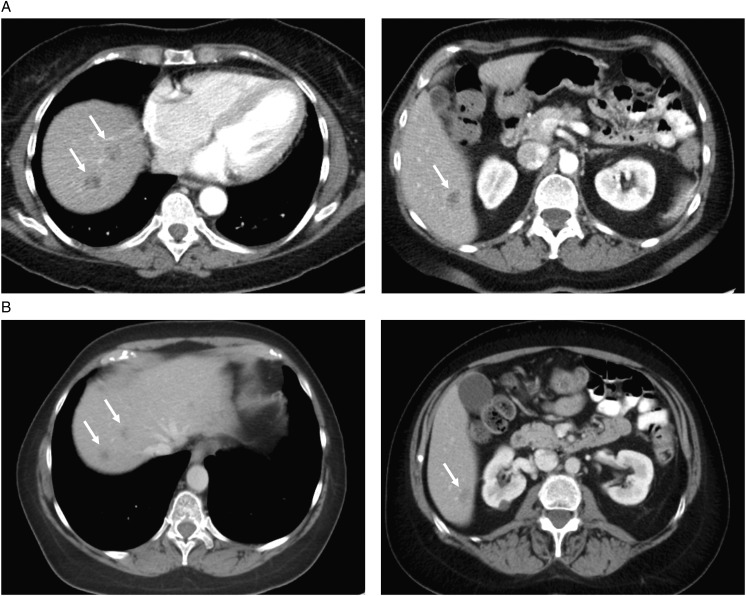
Computed tomography imaging. Computed tomography taken at (A) baseline before initiation of larotrectinib and (B) showing the best overall response of partial response to treatment with larotrectinib.